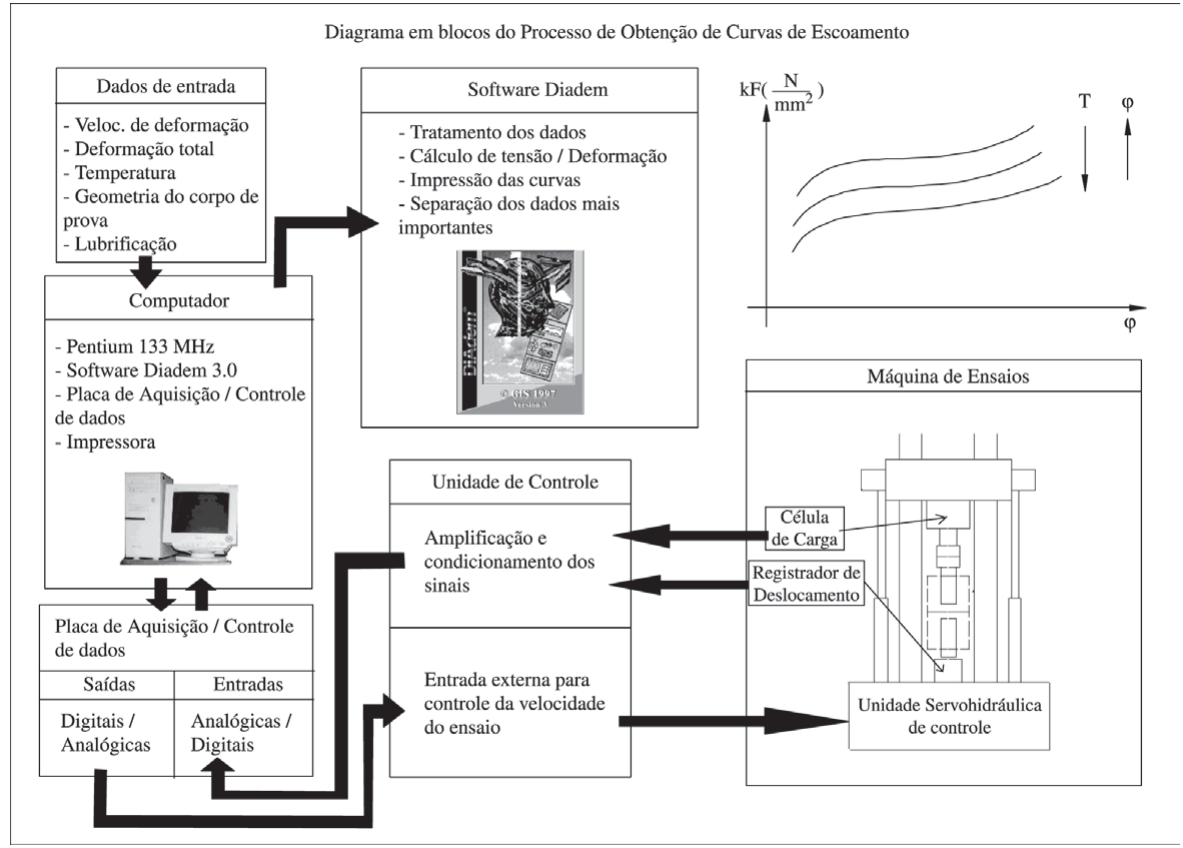
Figura 6. Esquema de controle da máquina de ensaios.